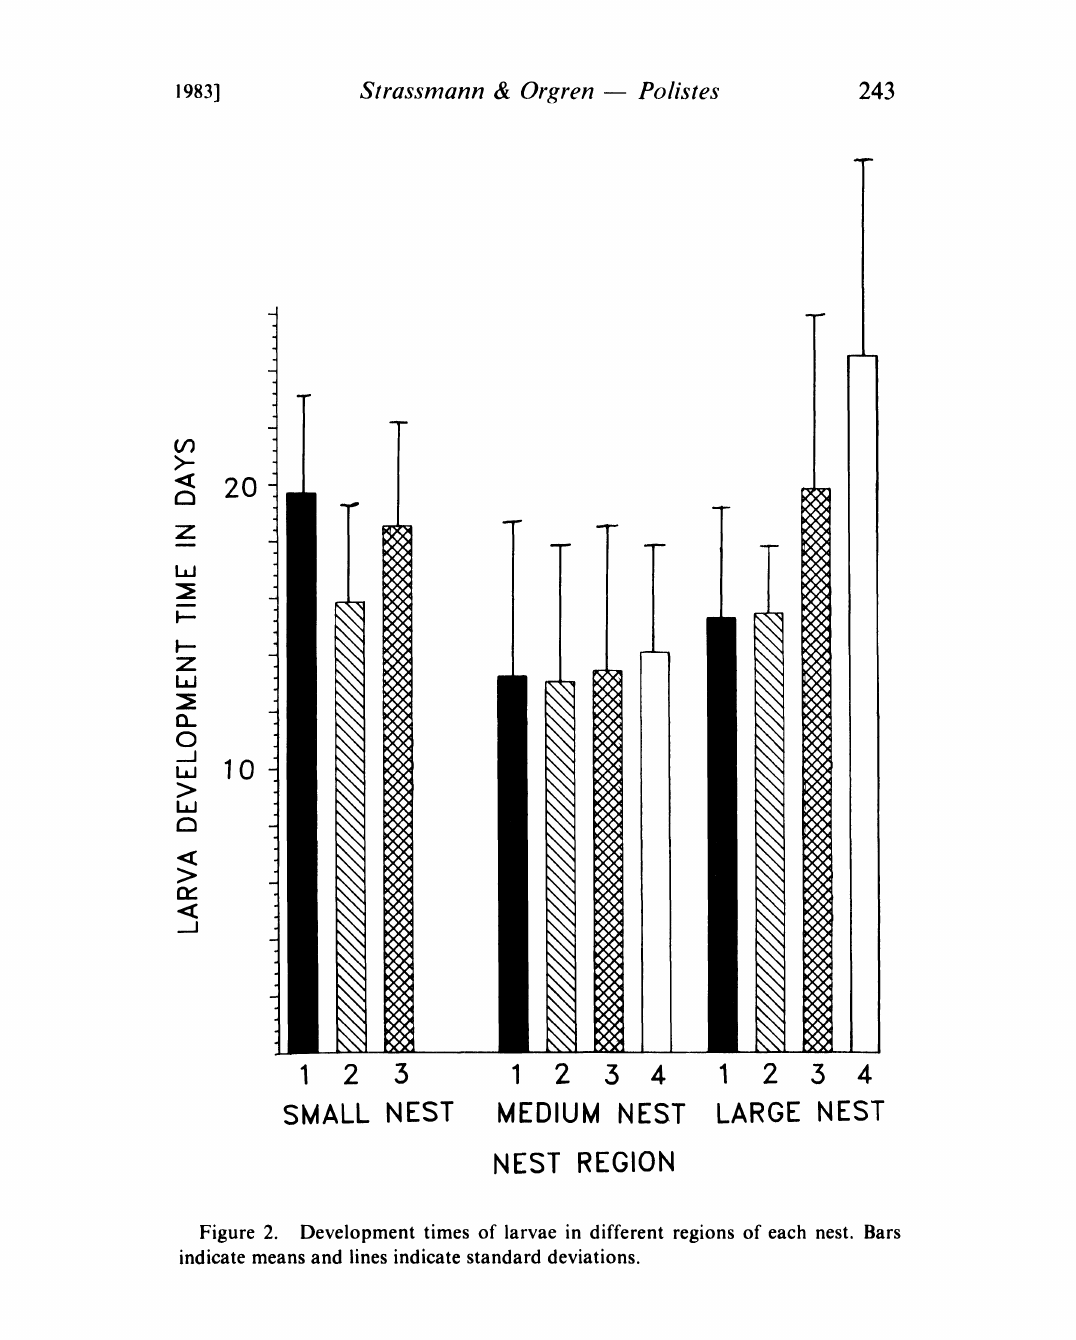
Figure 2. Development times of larvae in different regions of each nest. Bars indicate means and lines indicate standard